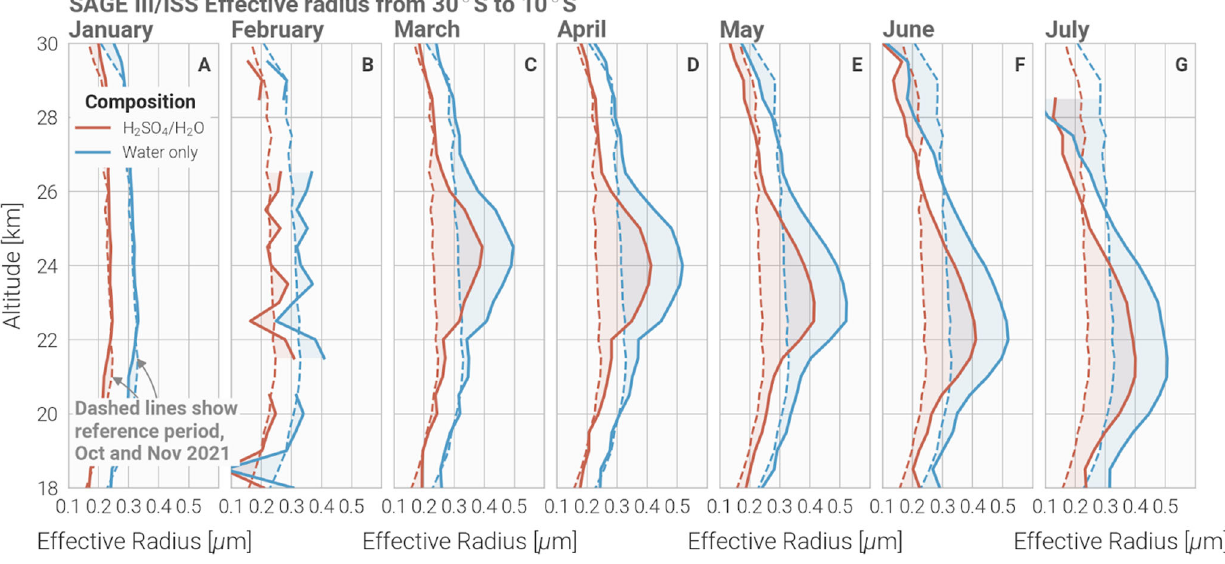
Fig. 9 Estimation of particle size from SAGE III/ISS multiwavelength data. The A – G show monthly averaged effective radius retrieved from SAGE III/ISS (January through July 2022, month indicated in each panel) assuming background (red) and pure-water (blue) aerosol composition. Dashed lines indicate the average effective radius pre-eruption, computed from October and November 2021 pro fi merged satellite dataset spanning 1979 – 2020 49 with the recent event in the last three decades. With that, the absolute magnitude aerosol extinction measurements by OMPS-LP and SAGE III of SAOD perturbation (embedded panel in Fig. 10c) by Hunga is satellite sensors. Figure 10c provides evidence that the Hunga at least a factor of 6 smaller than that of the previous major eruption led to a 4-5-fold increase in the stratospheric aerosol eruption of Pinatubo in 1991 and factor of 3 smaller than that of optical depth (SAOD), exceeding by far any volcanic or wild fi re El Chichon in 1982.